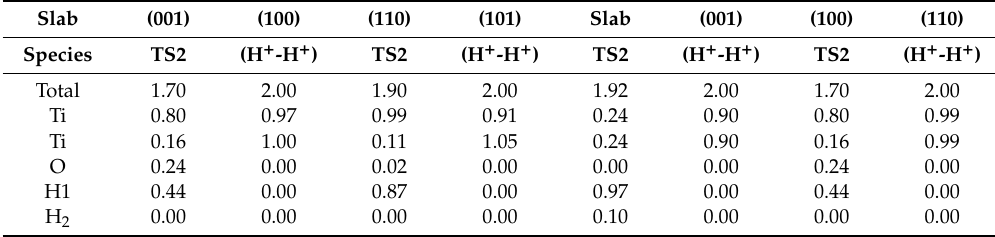
Table 4. The number of unpaired electrons of TS2 and (H + -H + ) species. Only involved atoms are